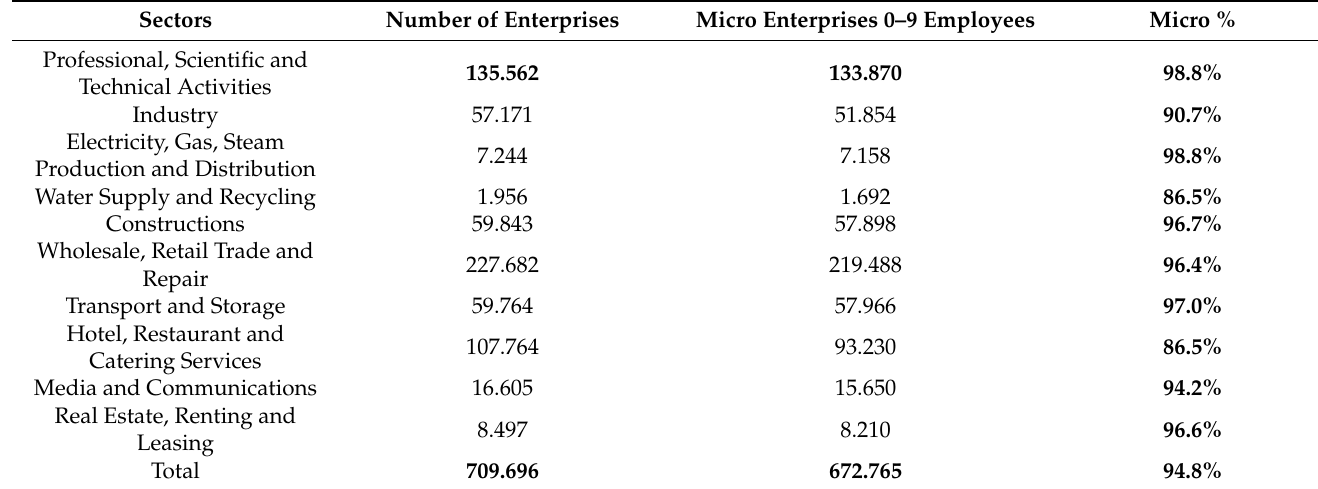
Table 2. Distribution of micro-enterprises/sector